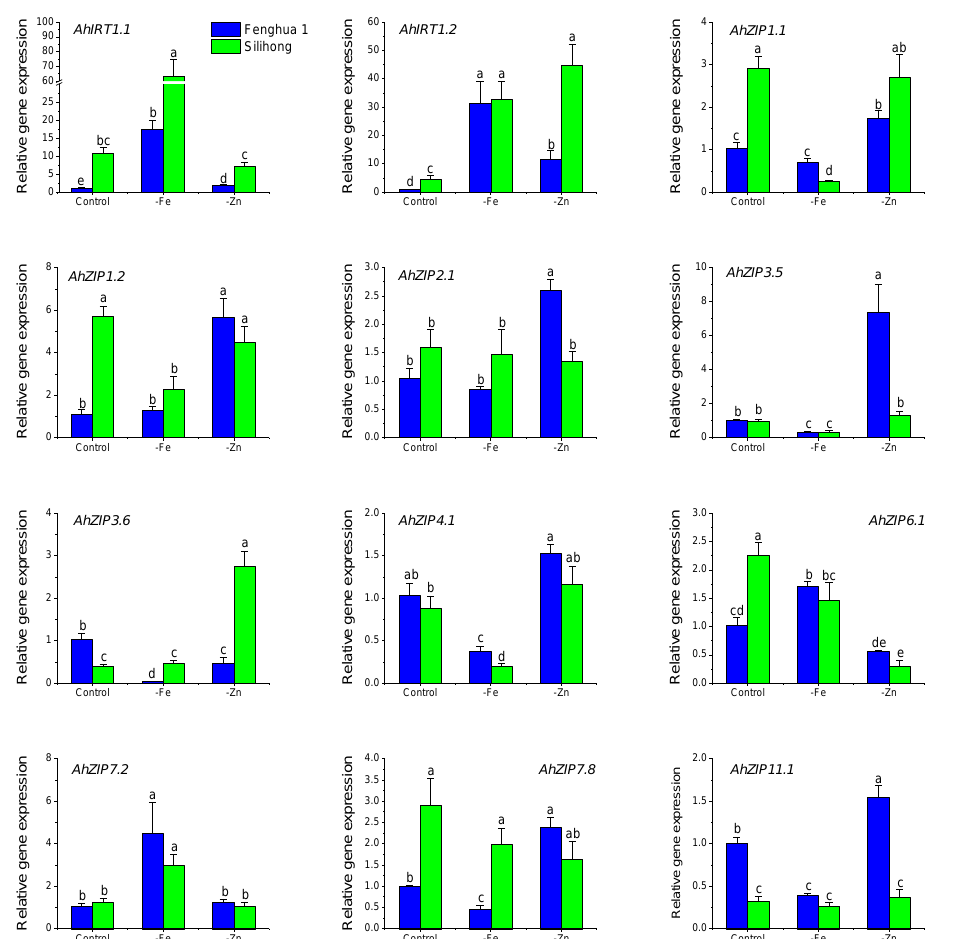
Figure 7. Expression levels of 12 AhZIP genes in the root of two peanut cultivars in response to Fe/Zn deficiency. Data (means ± SE, n = 4) sharing the same letter(s) above the error bars are not significantly different at the 0.05 level based on the Duncan multiple range test.